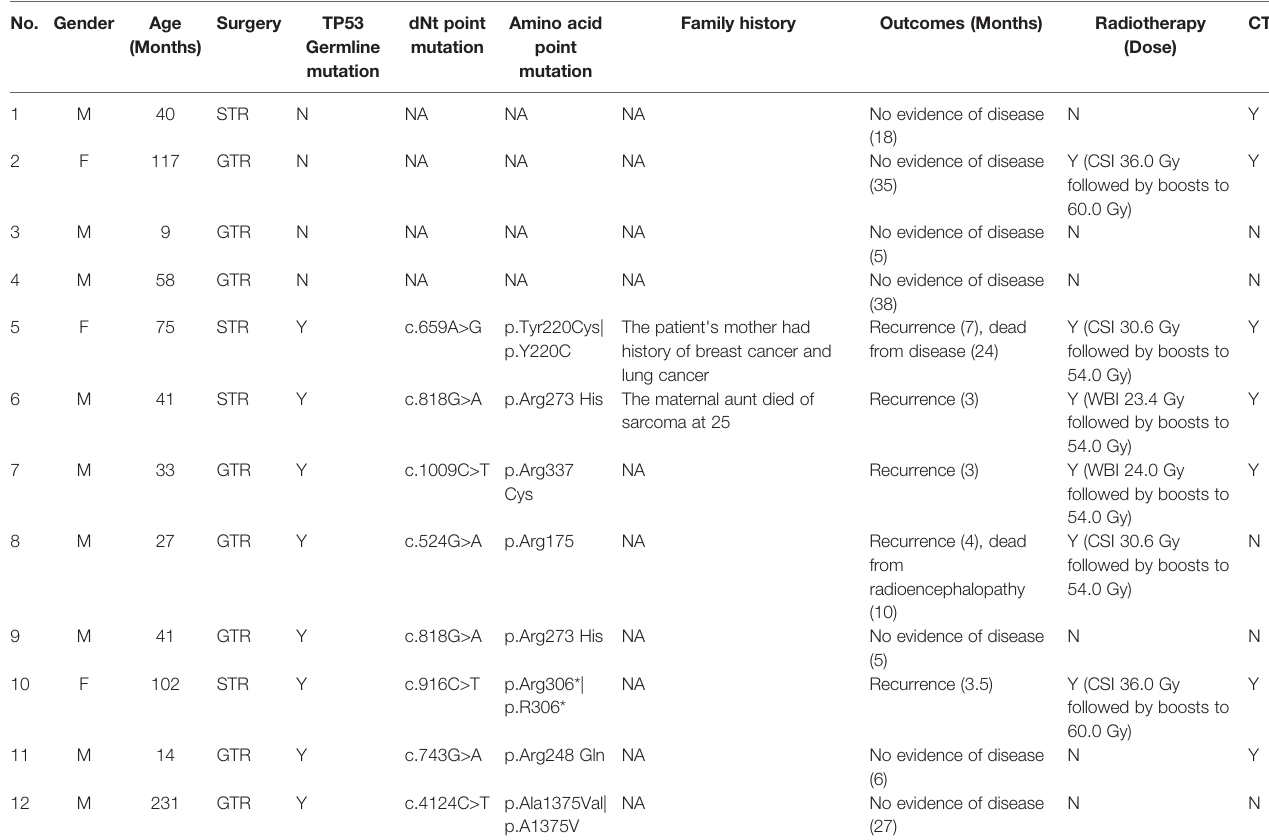
TABLE 1 | Characteristics of clinical and molecular in this study. No.